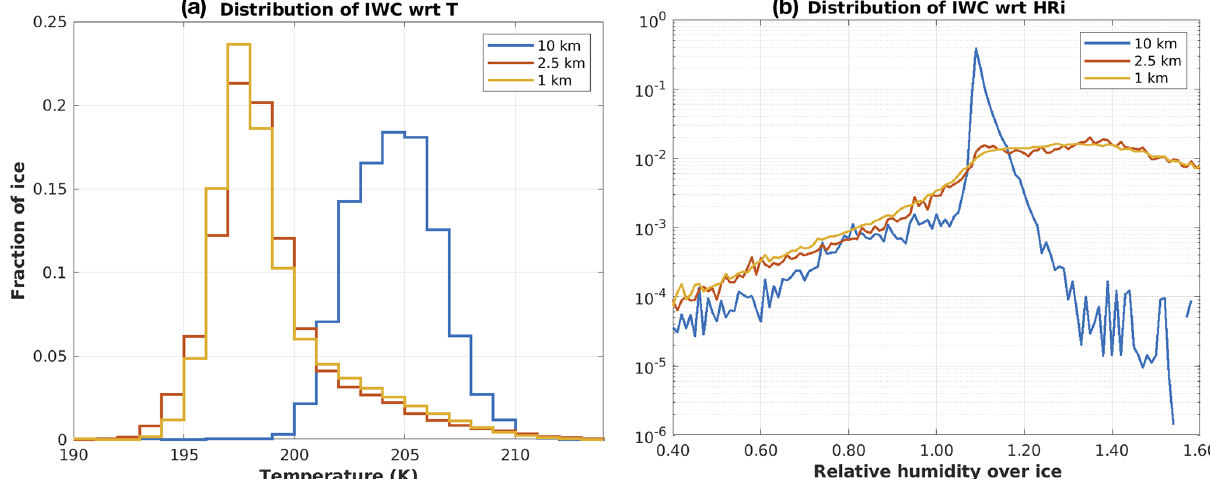
Figure 12. Distribution of ice with respect to (a) temperature and (b) relative humidity. The results are based on the variables in Domain A as shown in Fig. 11. The temperature and relative humidity intervals are 1K and 1%, respectively. The mass fraction value at each temperature or relative humidity interval is calculated by summing up the mass of ice in the grid boxes wherein temperature or relative humidity values fall within the specific interval and then dividing by the total mass of ice in the whole